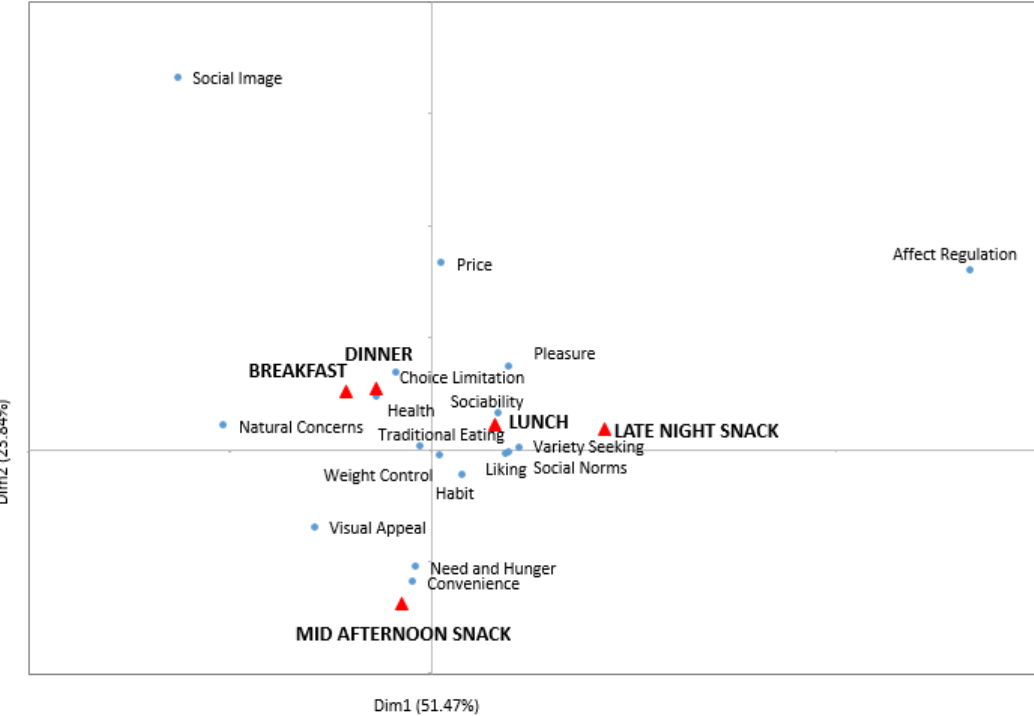
Figure 6. The Correspondence Analysis factor map representing five eating occasions and seventeen corresponding motivations. This factor map represents 75.31% of the total variance, with factor one contributing 51.47%, and factor two contributing 23.84% of the variance.